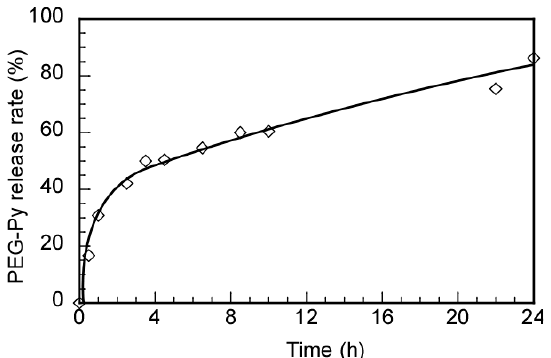
Figure 9. Release profiles of the encapsulated PEG-Py from the PIC vesicle.